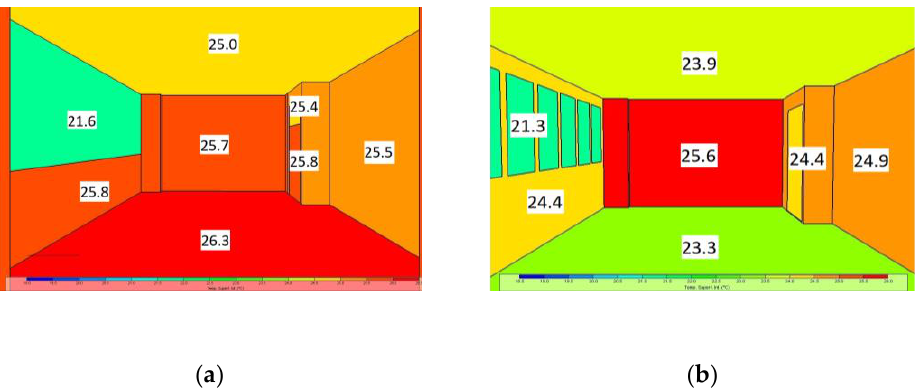
Figure 15. Models of Room W1, domain mesh, air intake, and outtake vents in red ( a ) as-is STD and ( b ) as-is T-BIM. Where: Vent 1 is ventilation air intake; Clim 1 – 3 are climatized air intake diffusors; Inf 1 – 7 are infiltrations of air through the window frames; Ext 1 – 2 are air extractions from the air conditioning system and through the door access.